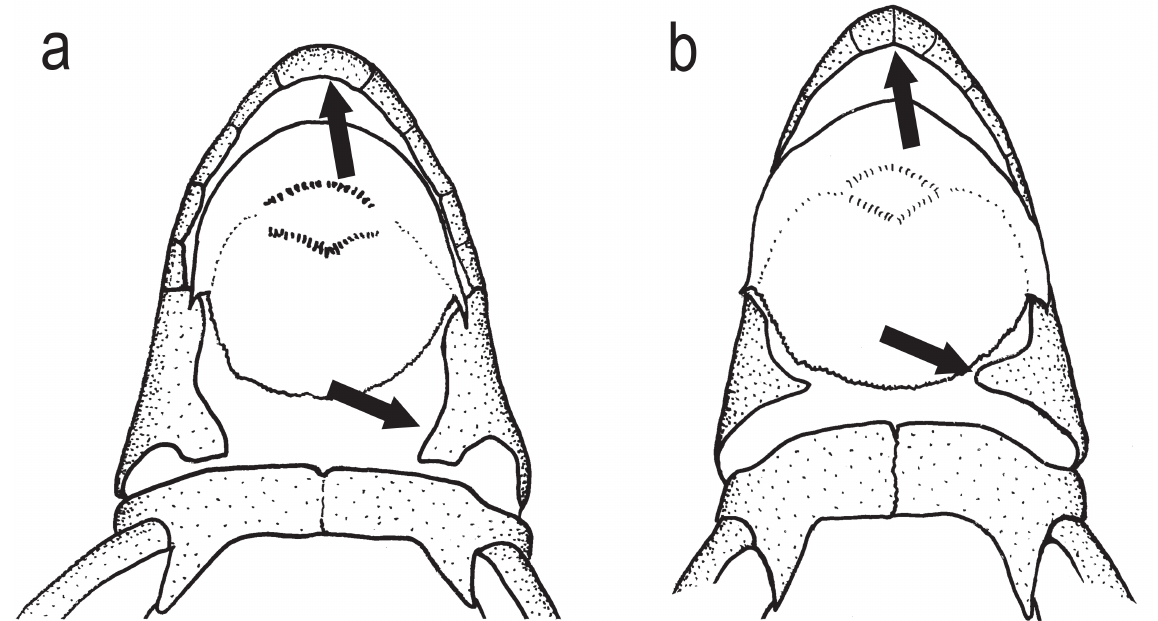
Fig. 6 . Schematic drawing of the ventral side of head and pectoral girdle of Curculionichthys species. a. C. hera , arrows point posteriorly directed canal plate and single rostral plate; b. C. scaius , arrows point mesially directed canal plate and double rostral